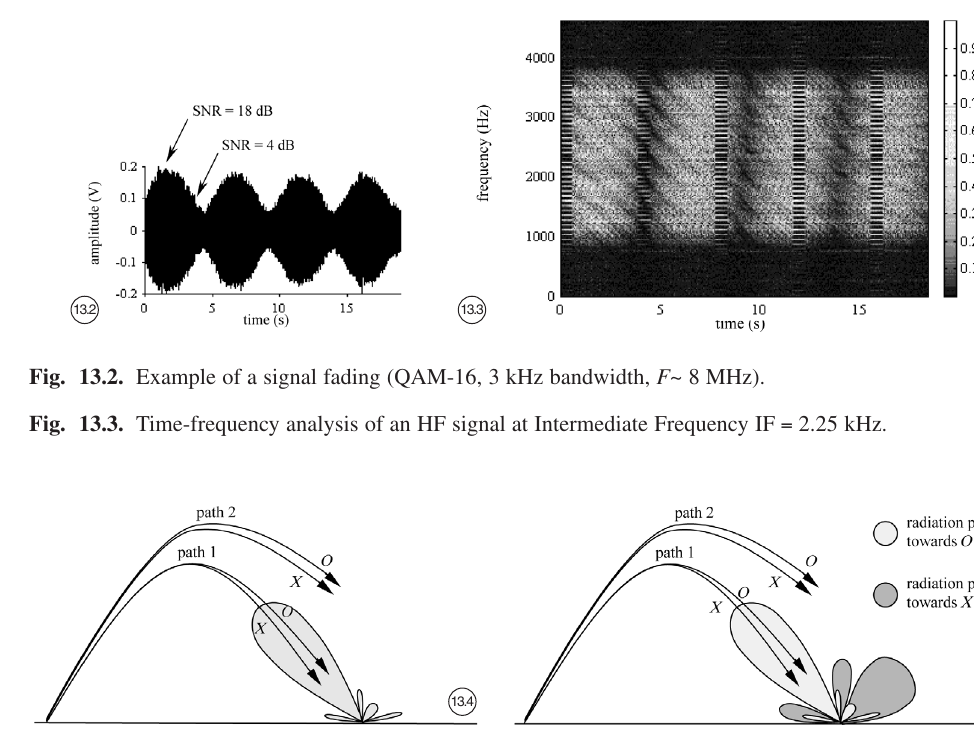
Fig. 13.4. Source separation with a classical array. Fig. 13.5. Source separation with a heterogeneous